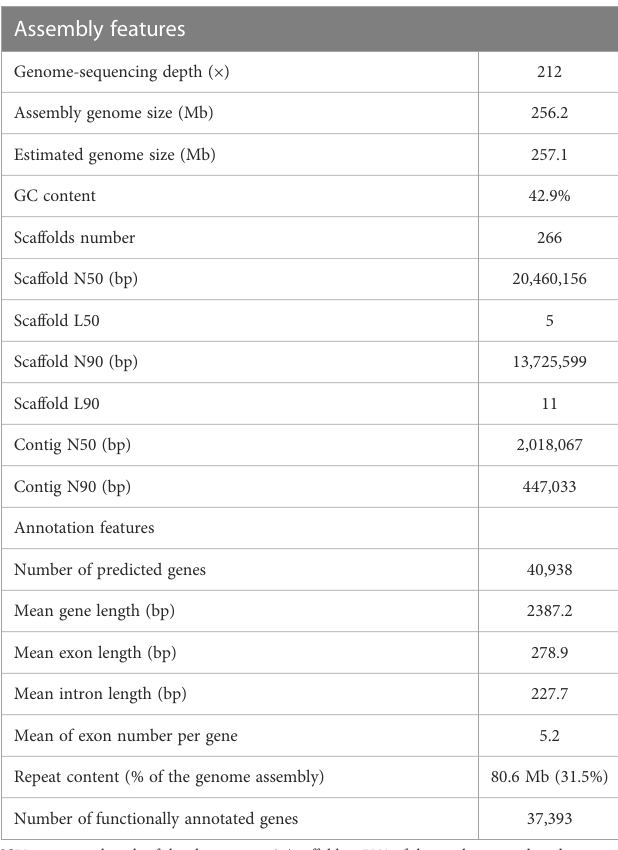
TABLE 1 Summary of genome assembly and annotation for Melastoma candidum . Assembly